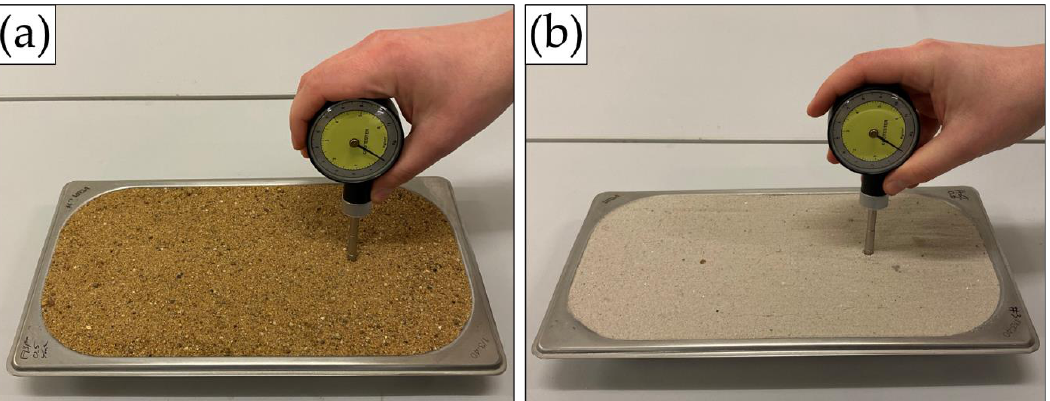
Figure 3. Hand-held pocket penetrometer testing. ( a ) Medium-grained sand sample; ( b ) fine-grained silica sand sample.